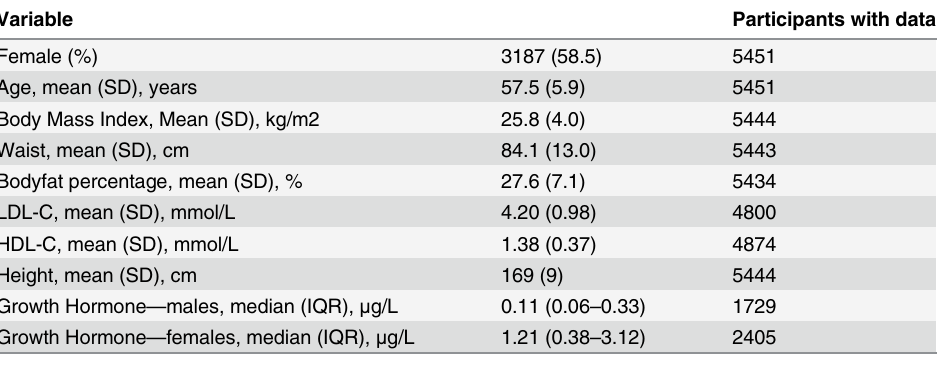
Table 1. Clinical characteristics of the study population.